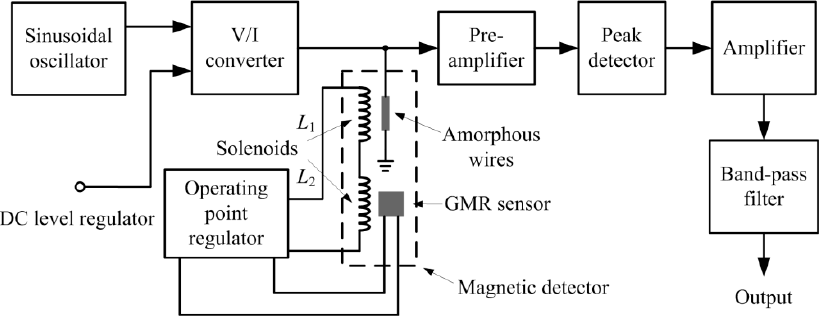
Figure 2. Block diagram of the developed GMI sensor.